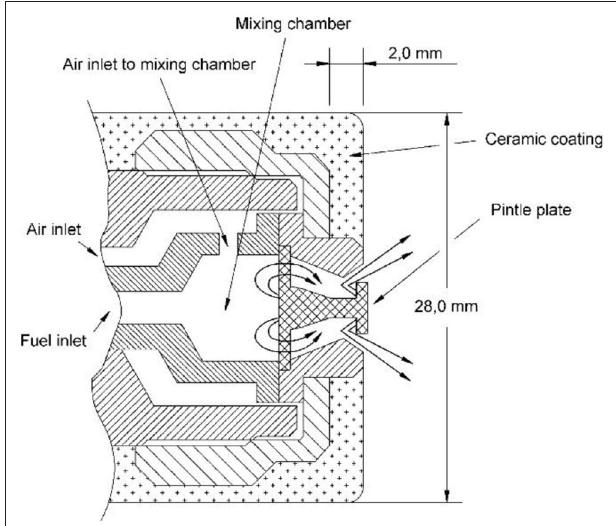
FIGURE 5 | Swirl-air nozzle cross section.